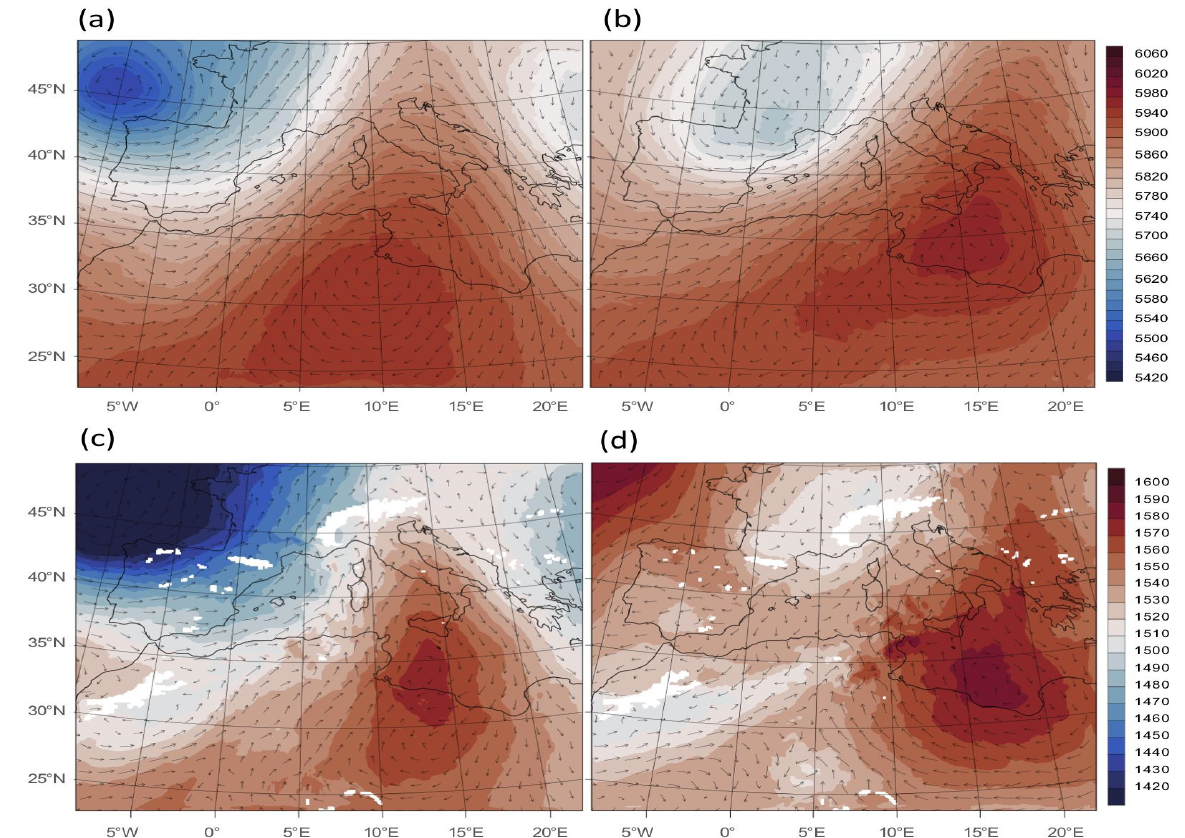
Figure 5. WRF-Chem geopotential height (m) and wind vectors at 500 hPa (upper panels) and 850 hPa (bottom panels), for 20 June at 12:00 UTC ( a , c ) and for 24 June at 00:00 UTC ( b , d ). The large-scale patterns at 500 hPa and 850 hPa described above both appear